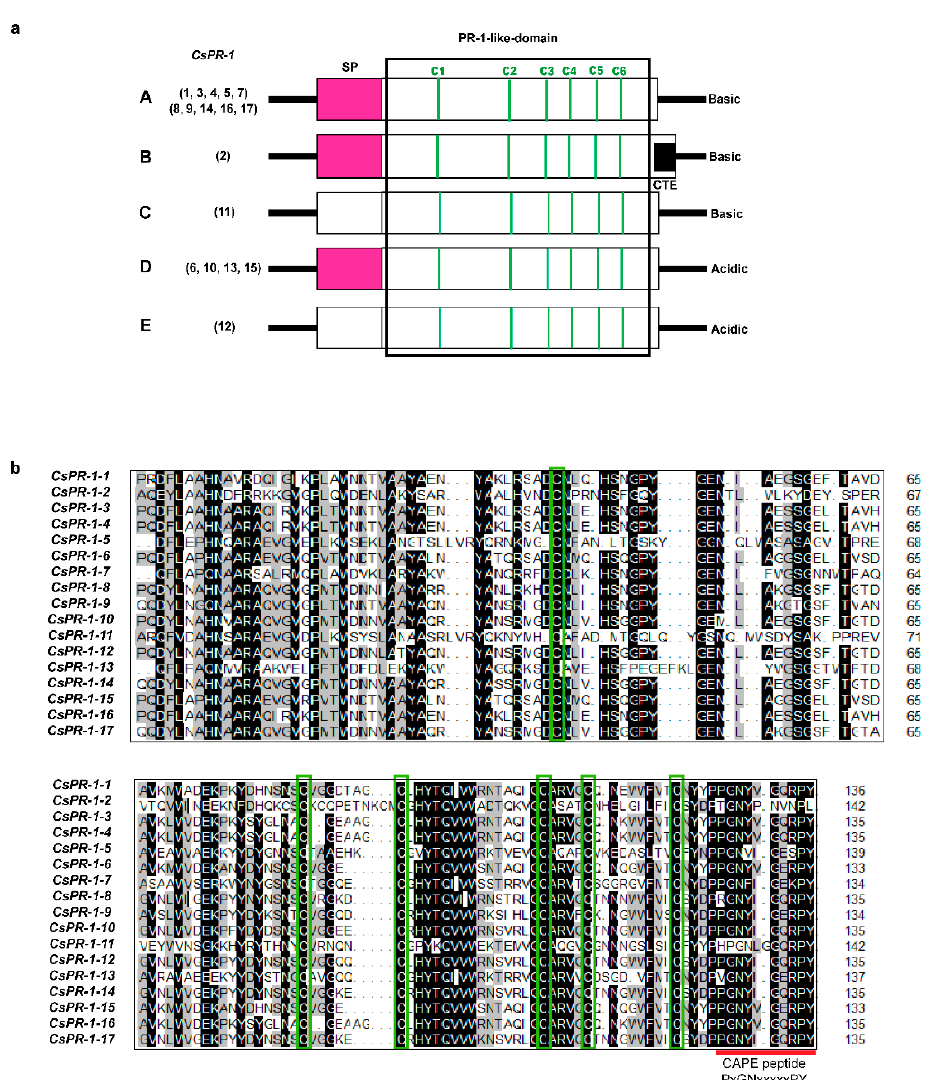
Figure 1. Genomic and domain structures of the CsPR-1 genes. ( a ) Diagram of the genomic structures of the CsPR-1 genes. Open boxes signify the open reading frames (ORFs). Signal-peptide (SP) regions are shaded in pinkish red. Vertical green solid bars represent the positions of the six conserved cysteine residues (C1-C6). The box drawn with black solid lines indicates the conserved PR-1-like domains (pfam cd05381). The interior black box indicates the C-terminal extension (CTE). ( b ) Amino-acid alignment of the PR-1-like domain of the deduced CsPR-1 proteins. DNAMAN 7.0 was used to mark the amino-acid residues with an identity of more than 50% with black shade. The areas in the interior green boxes and the red solid line indicate the C1-C6 and CAPE peptide, respectively.